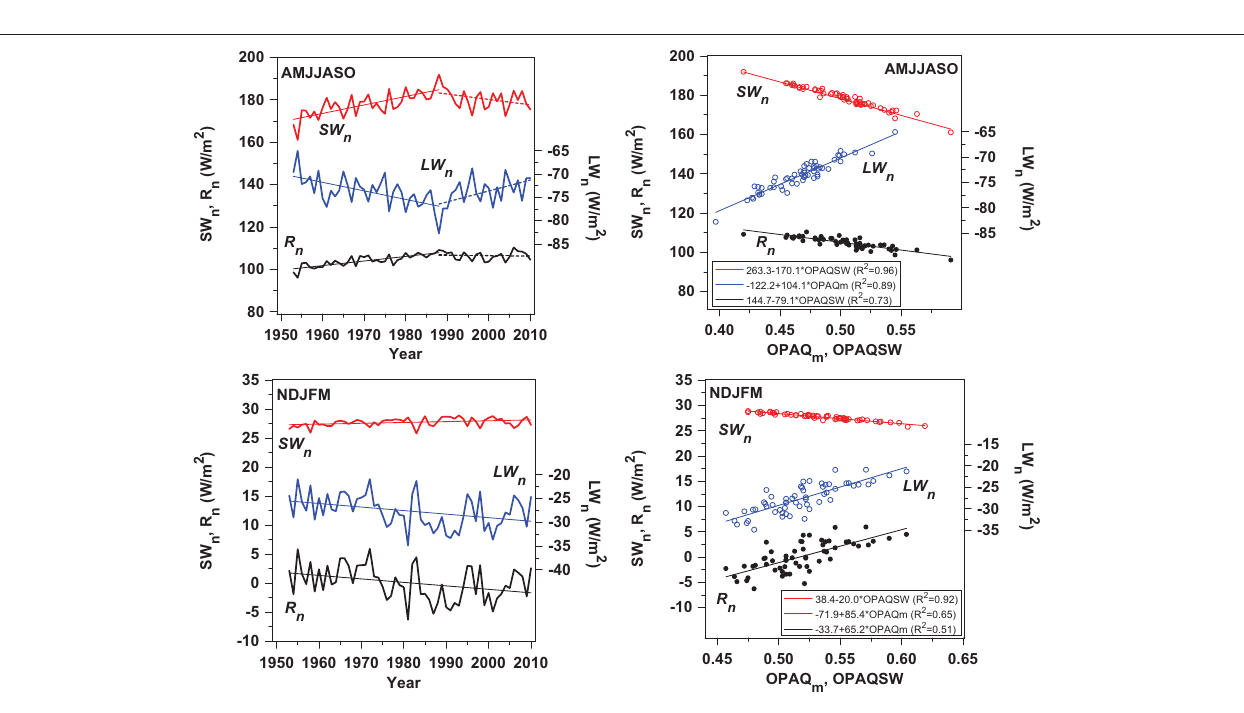
Frontiers in Earth Science |